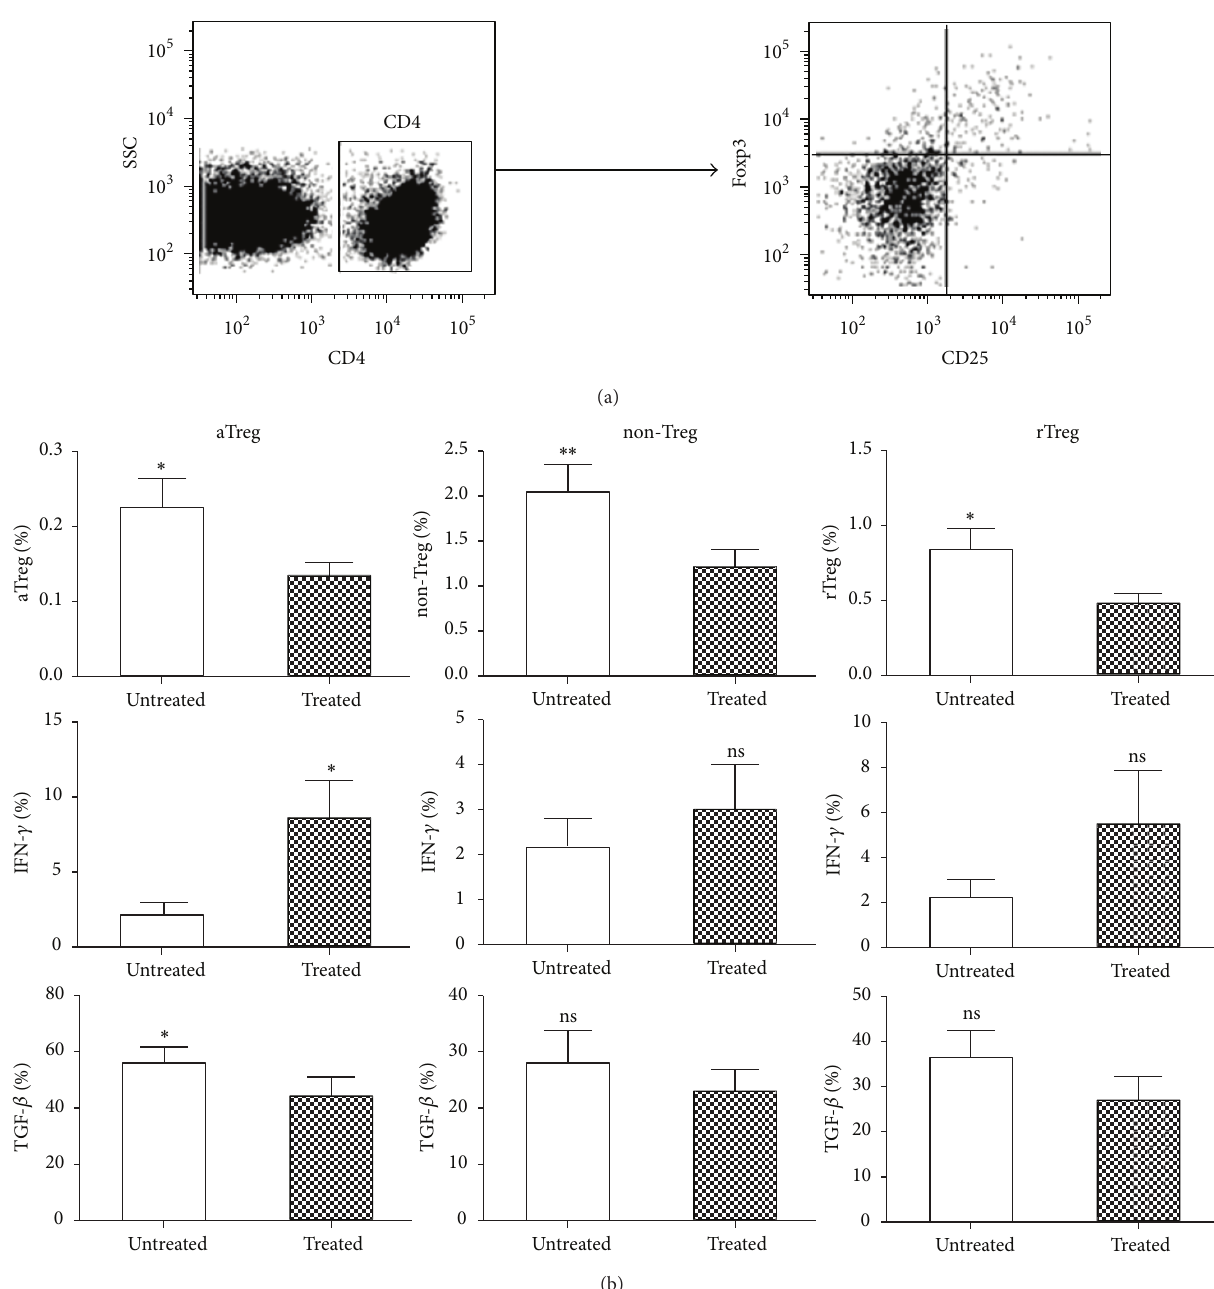
Figure4:ThethreeTregsubsetsreducedafterbeingtreatedwithdocetaxel invitro .(a)PBMCsfromNSCLCpatientswerestainingwithCD25 and Foxp3 antibody and analyzed by flow cytometry. (b) The peripheral blood of NSCLC patients was collected and CD4 + CD25 + T cells were isolated by flow cytometric sorting. Three Treg subsets were defined with CD4 + CD45RA − CD2 5 hi (aTreg) cells, CD4 + CD45RA − CD2 5 lo (non- Treg) cells, and CD4 + CD45RA + CD2 5 lo (rTreg) cells. The differences of three subsets with or without docetaxel were analyzed. ∗ 𝑃 < 0.05 ; ∗∗ 𝑃 < 0.01 by paired 𝑡